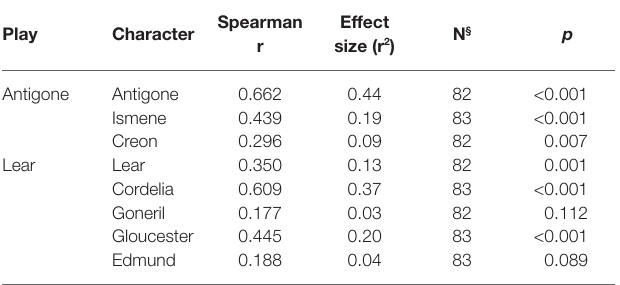
TABLE 6 | Correlations between mean identification and moral approval ratings for each